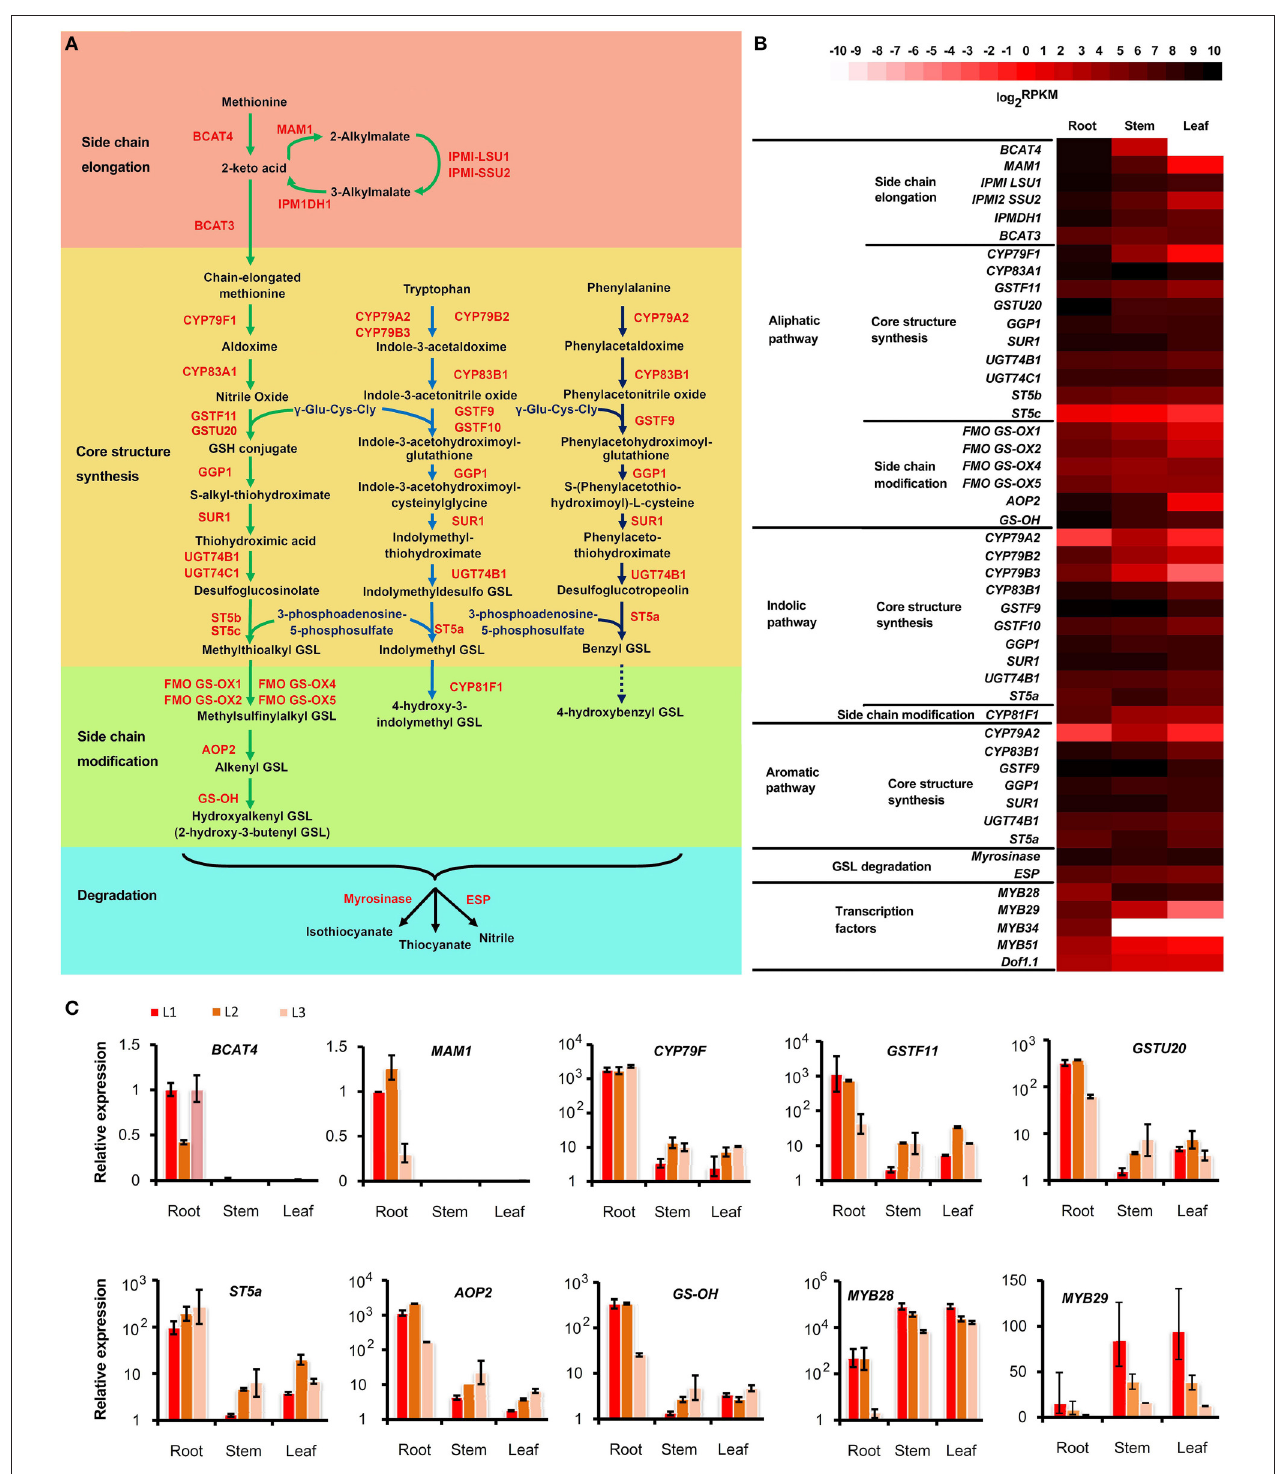
FIGURE 8 | Glucosinolate (GSL) metabolic pathway and its tissue pattern in Sinapis alba. (A) Pathway map. (B) Heatmap showing the expression level of genes encoding the enzymes and regulators in the GSL pathway. (C) qPCR results. Bars indicating SDs of technical replicates. BCAT, branched-chain amino acid aminotransferase; MAM, methylthioalkylmalate synthase; IPMI LSU1, Isopropylmalate Isomerase Large Subunit 1; IPMI SSU2, Isopropylmalate Isomerase Small Subunit 2; IPMDH, Isopropylmalate Dehydrogenase; CYP, Cytochromes P450; GSTF, Glutathione S-transferases; GGP, Gamma-Glutamyl Peptidase; SUR, C-S lyase SUPERROOT; UGT, UDP-glucosyltransferase; ST, Desulfoglucosinolate Sulfotransferases; FMO-GSOX, Flavin-Monooxygenase Glucosinolate S-Oxygenase; AOP, Alkenyl hydroxalkyl producing; GS-OH, Fe (II)-dependent oxygenase superfamily protein; ESP, epithiospecifier protein.